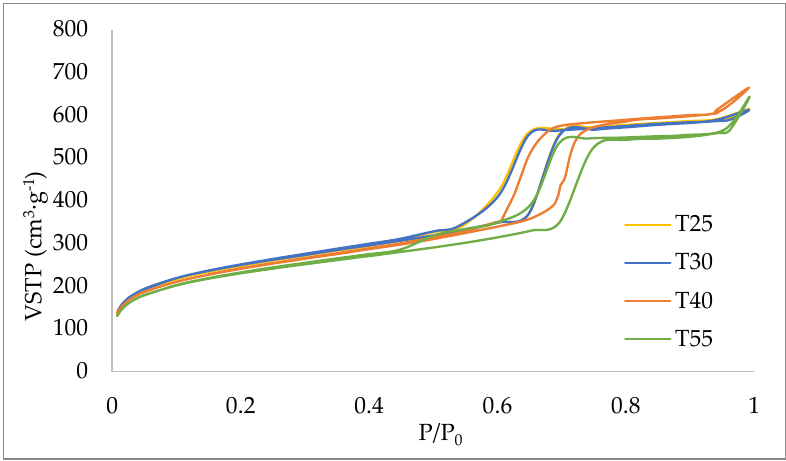
Figure 5. N 2 adsorption isotherms corresponding to the samples for temperature study.